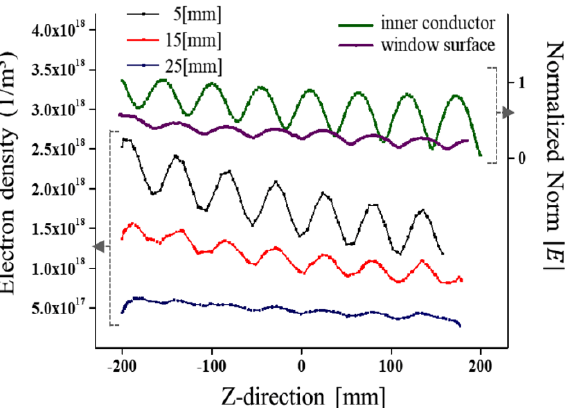
Figure 12. Attenuation of electron density along the axial direction (Z-axis) in the XZ plane (quasi- coaxial TEM mode), distance (5 mm, 15 mm, and 25 mm for black, red, and blue lines, respectively) from the window surface along the X-axis, normalized norm | E | on the inner conductor (green line), and the window surface (purple line) are to compare the electron density distribution along the E-field.